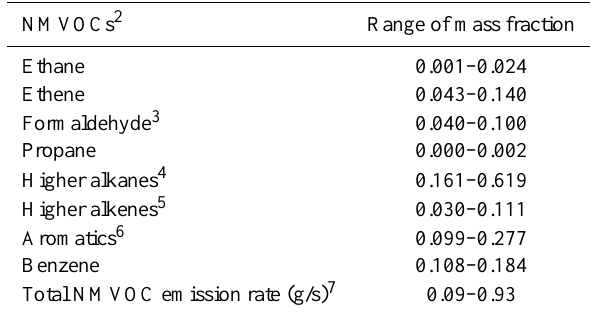
Table 1. Estimated ranges of the NMVOC mass-fractions and emis- sion rates from ships 1